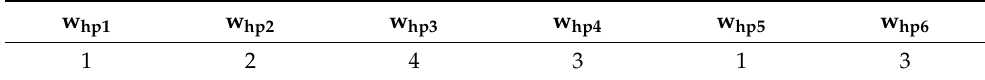
Figure 4. Average values of energy consumed by the electric bus, depending on the time of day. The entire travel period was divided into six time intervals, and for the purpose of training the neural network, the peak hour parameter thp n was assigned the values (w hp1 –w hp2 ) presented in Table 3. Table 3. Peak hours w hp coding